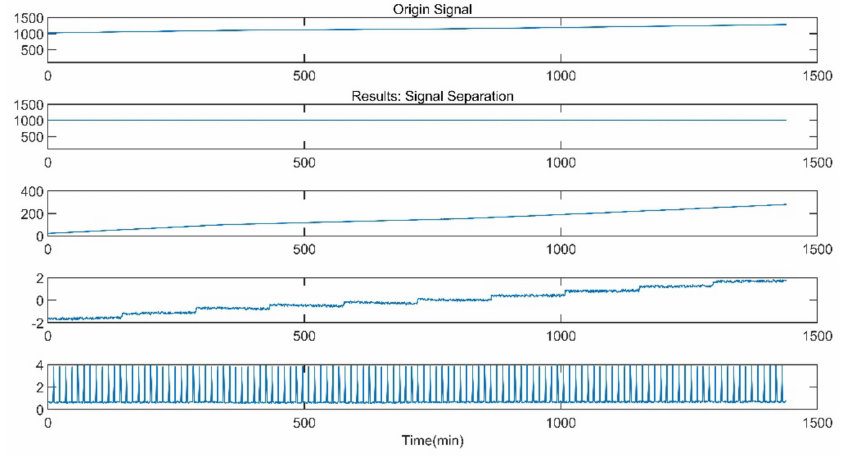
Figure 11. Separation Result of Drift